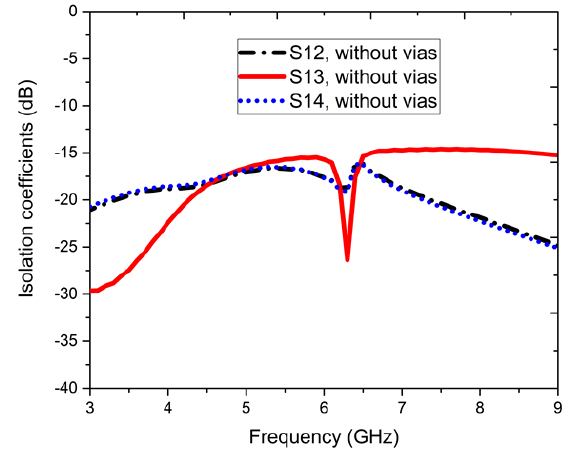
Figure 7. Isolation parameters, dB without vias for the four-element antenna configuration.